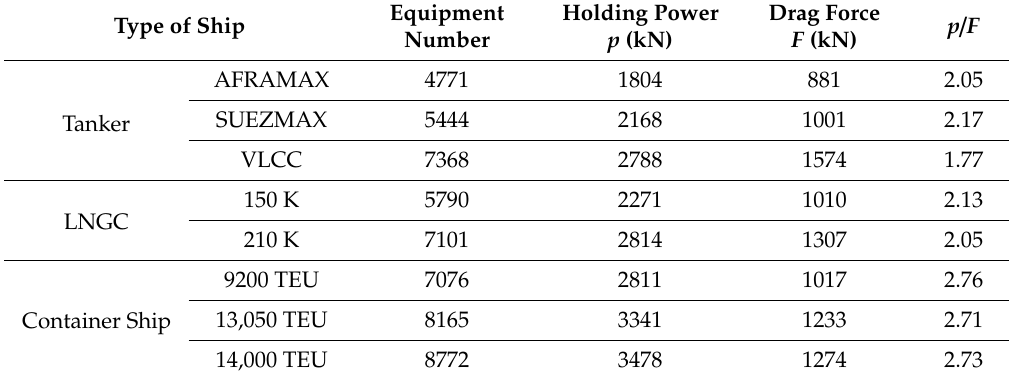
Table 4. Comparison between holding power ( p ) and wind and current forces ( F